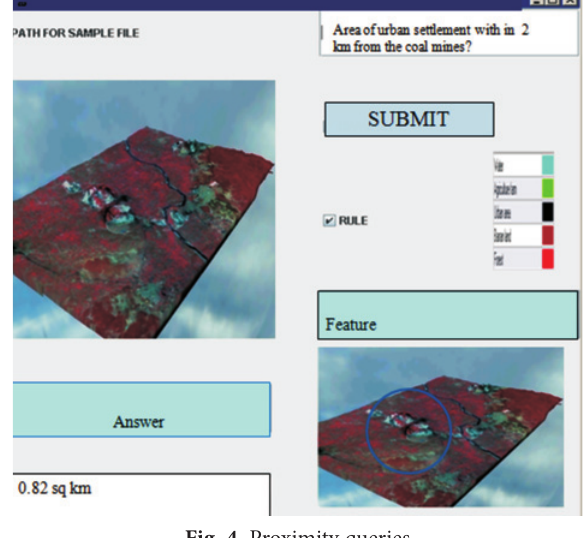
Fig. 4. Proximity queries